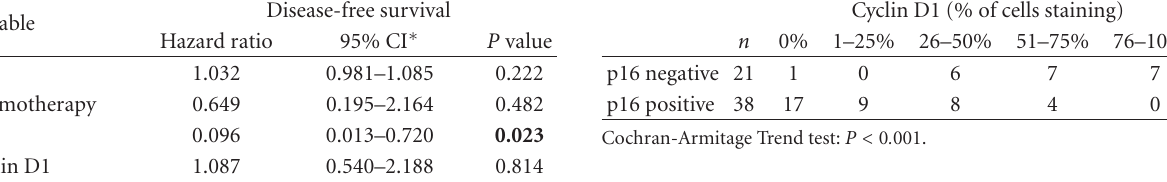
Table 6: Tumor counts stratified by p16 and cyclin D1 staining. Cyclin D1 (% of cells